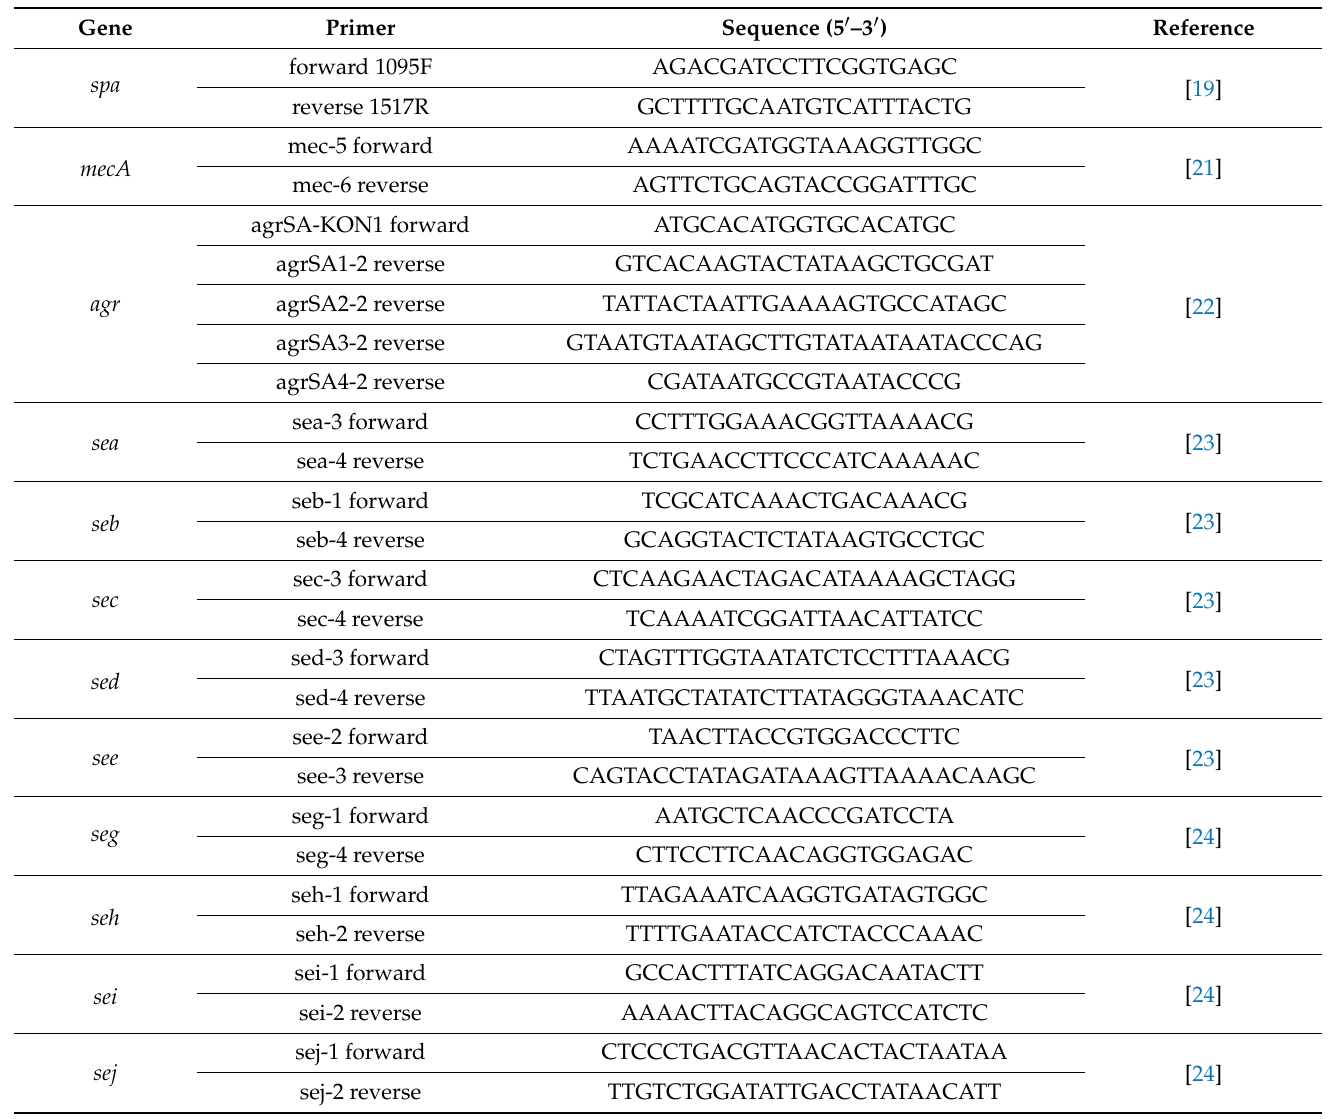
Table 2. Primers used for spa typing and single and multiplex